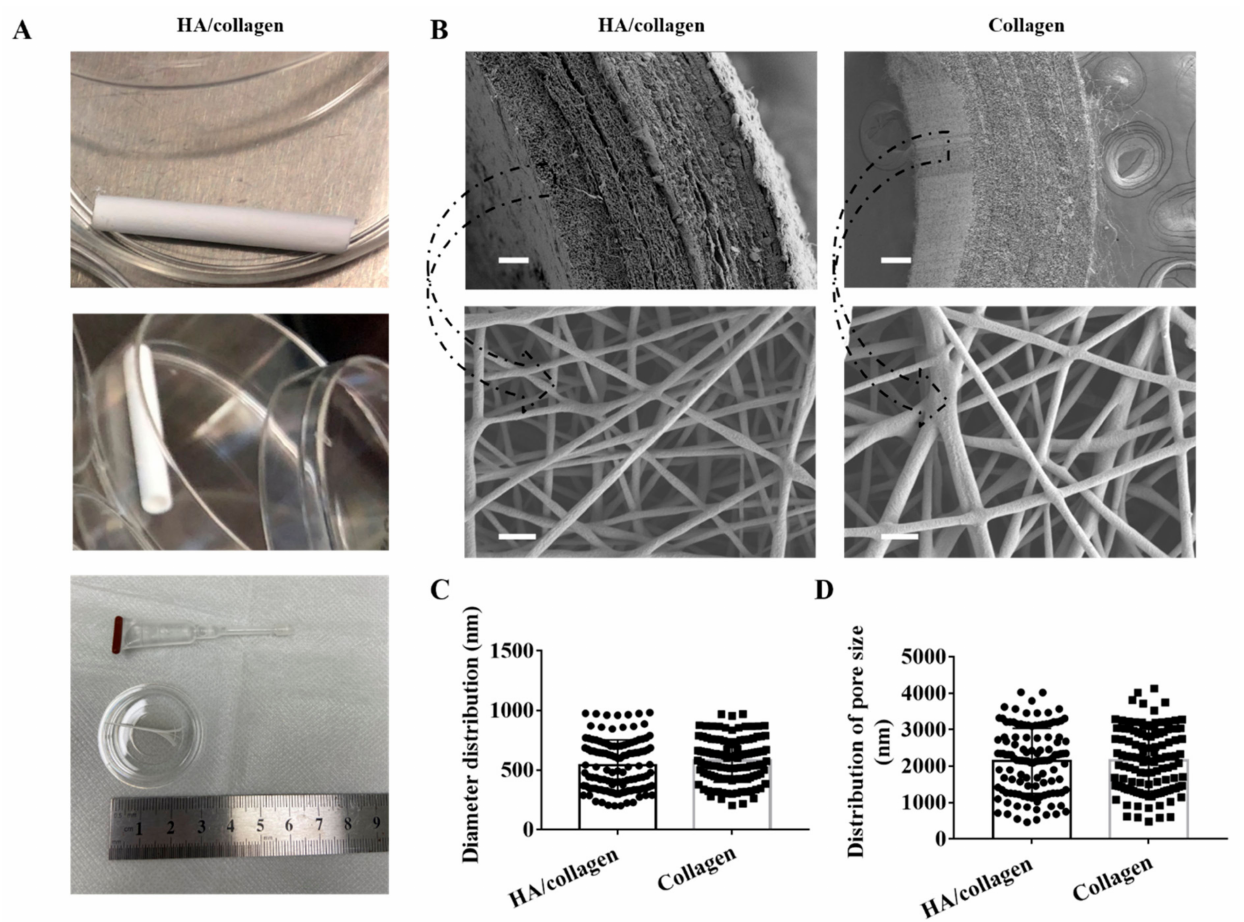
Figure 1. Physical characteristics of electrospun nanofibers. ( A ) The lateral (upper panel), cross-section (middle panel) and strip nanofiber concentric axis film (after cutting along long axis) view of an HA/collagen nanofiber tube. ( B ) SEM micrographs of the cross-section (upper panel) views and the inner wall surface (lower panel) views of HA/collagen and collagen nanofibers before cross-linking. Scale bars: 100 µ m (upper panel), 2 µ m (lower panel). Statistical data of the diameter ( C ) and pore size ( D ) distribution of various